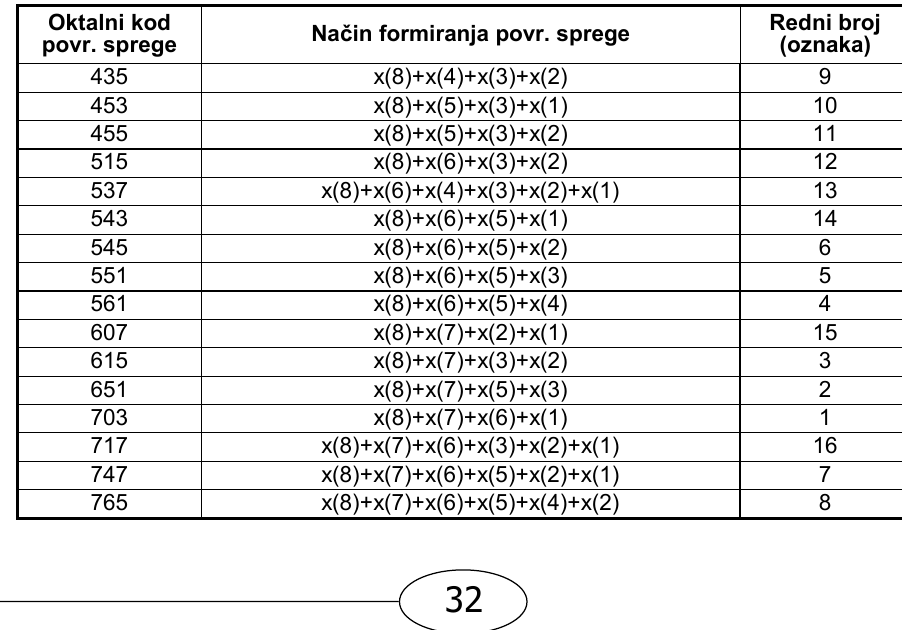
m-sekvence dužine L =